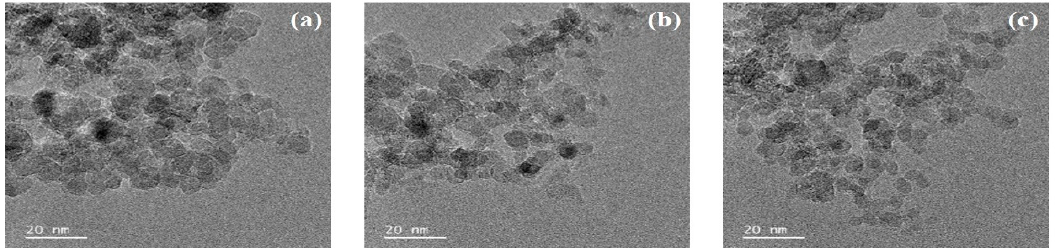
Figure 1. Transmission electron microscope (TEM) images of ( a ) NDs; ( b ) LF (10 μ g)-NDs; ( c ) LF (50 μ g)-NDs. Scale bar: 20 nm.